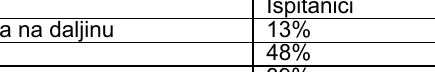
Poželjan na č in studiranja Oblik obrazovanja Ispitanici Tradicionalne studije bez elemenata u č enja na daljinu 13% Program udaljenog u č enja 48% Kombinovani program 39%